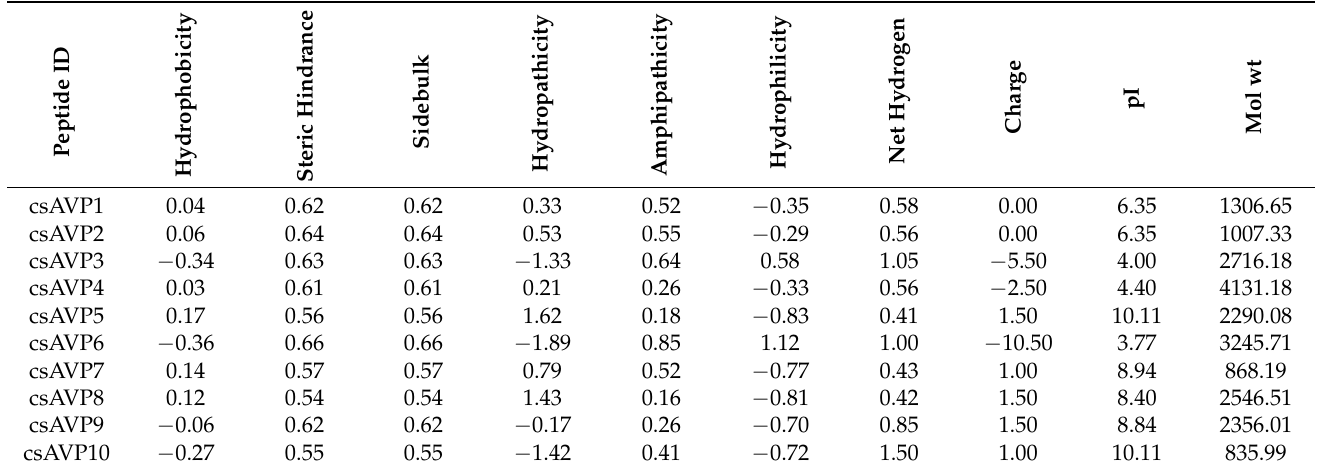
Table 3. Physicochemical properties scores of ten selected csAVPs (csAVP1 to csAVP10) calculated by ToxinPred server.